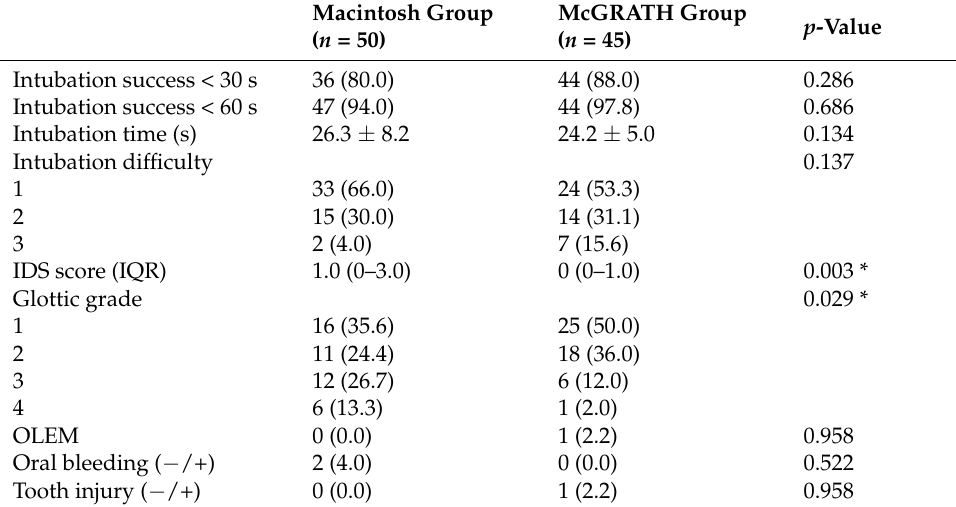
Table 2. Intubation